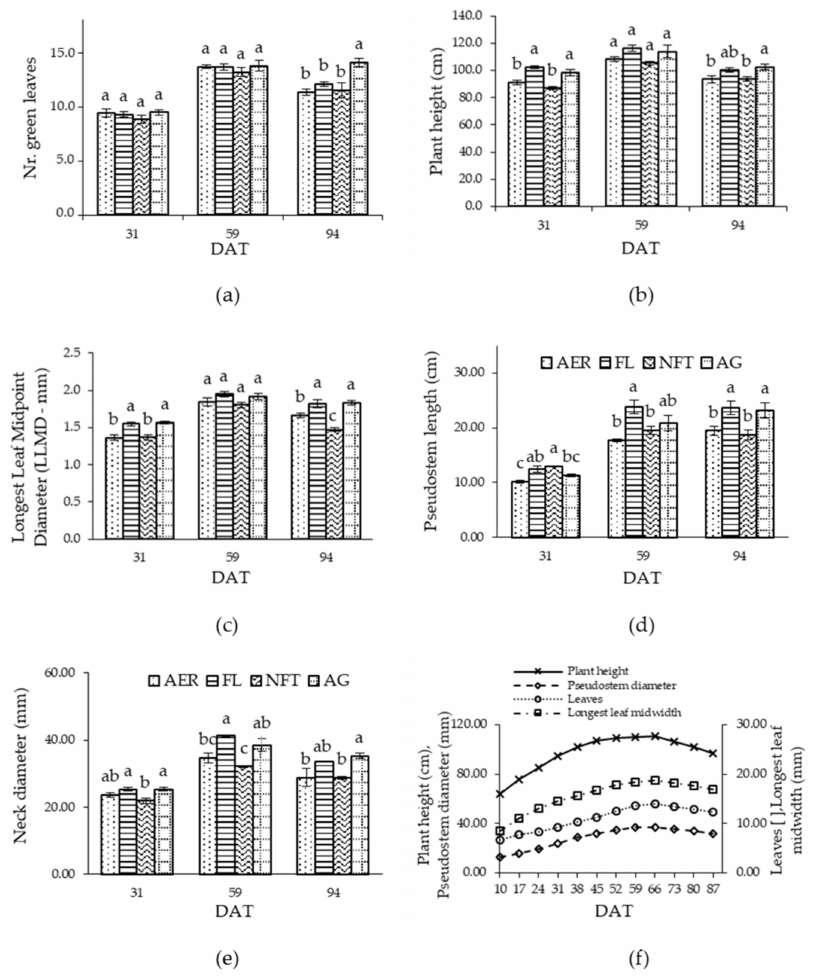
Figure 3. Impact of the CSCS on vegetative development: ( a ) number of green leaves; ( b ) plant height (cm); ( c ) longest leaf midpoint diameter (LLMD); ( d ) pseudostem length (cm); ( e ) neck diameter (mm) at about monthly intervals, i.e., 31, 59, and 94 DAT, ( f ) the average vegetative development of CSCS as indicated by the weekly samplings of plant height (cm), pseudostem width (mm), the number of green leaves, and longest leaf midpoint diameter (mm). Vertical bars indicate ± standard errors of means of ten (10) measurements per replicate. Similar letters indicate non-significant differences at p ≤